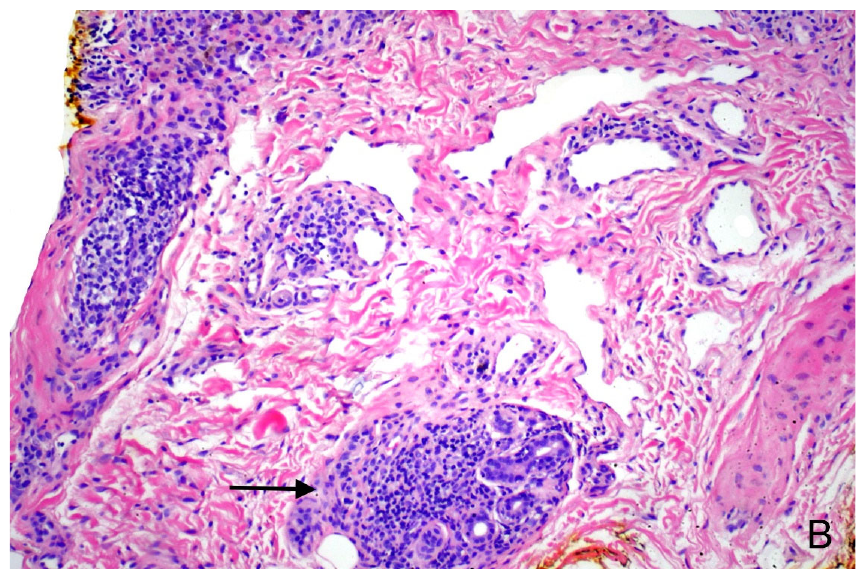
Figure 9b Figure 9. V-ILE Case 4, lichen striatus-like. ( A ) Lichenoid dermatitis, patchy in areas, with a superfi- cial and deep lymphocytic infiltrate. The deep infiltrate surrounds eccrine glands (arrow). Prominent pigmentary incontinence is seen in the papillary dermis. (Hematoxylin-eosin stain; Original mag- nification, × 100). ( B ) Perieccrine lymphocytic infiltrate is shown at a higher magnification (arrow). (Hematoxylin-eosin stain; Original magnification, ×